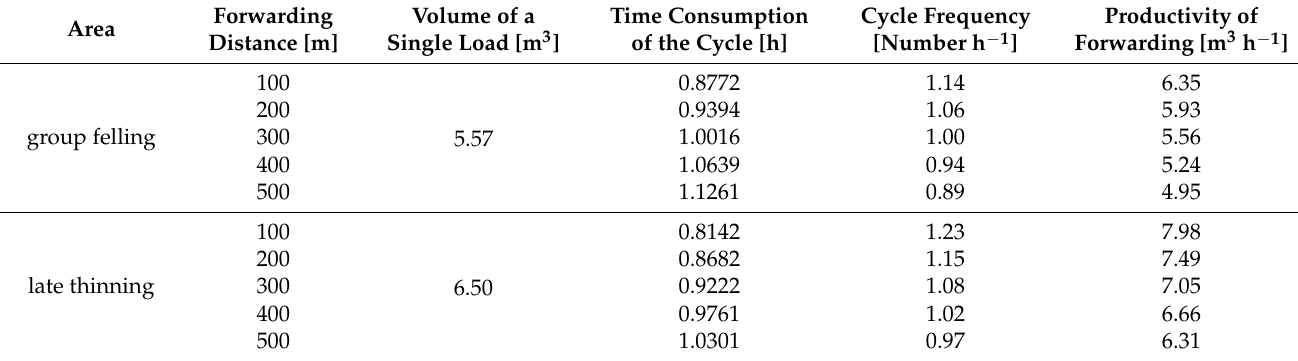
Table 4. Productivity of forwarding with the studied unit [m 3 h − 1 ].